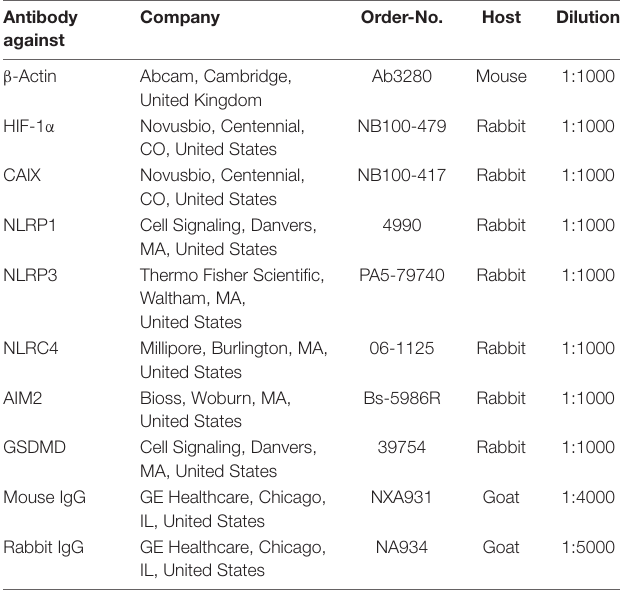
TABLE 1 | List of antibodies used for Western blotting. Antibody Company against